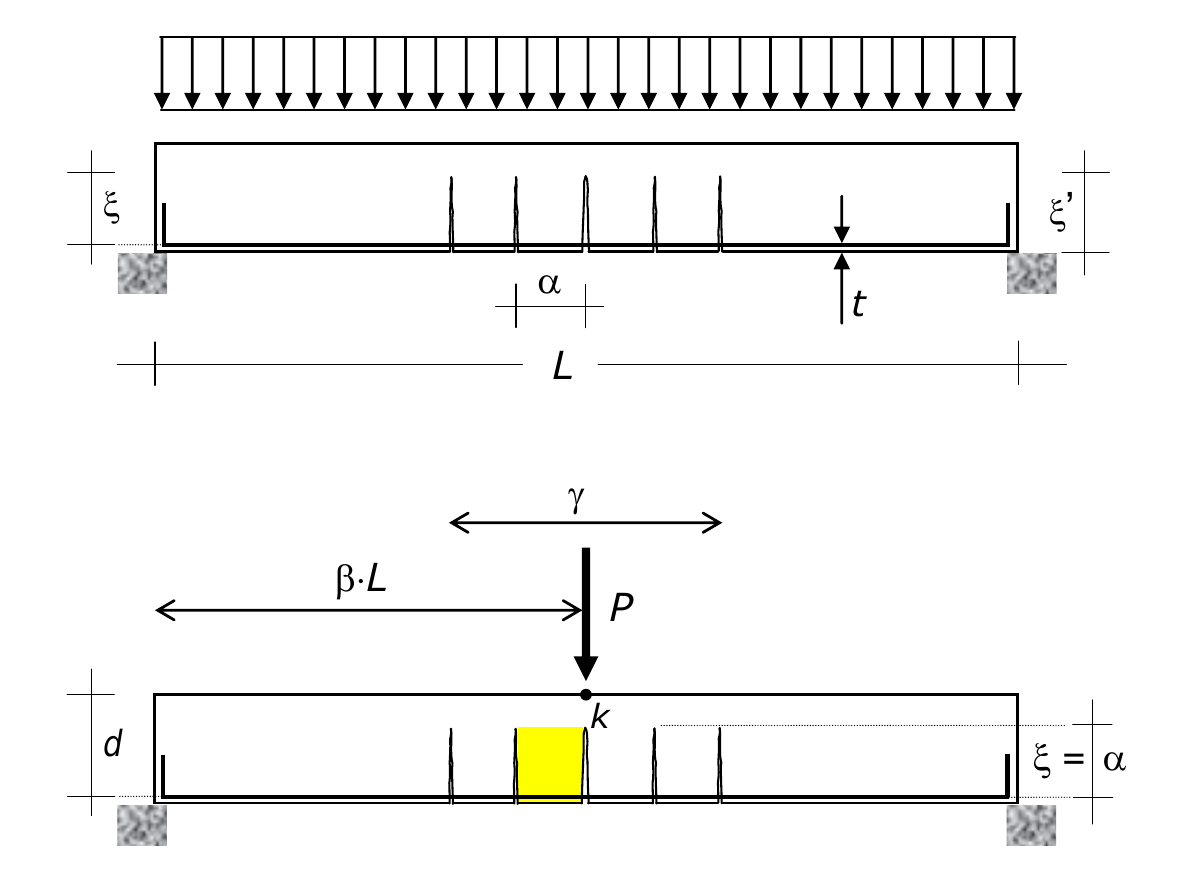
Figure 1. RC beam with vertical cracks around the midspan, which are spread along the length γ at spacing α. The upper diagram shows the loading condition that acted in the past and cracked the beam. The lower diagram shows the unstrengthened beam subjected to the new loading condition, i.e., the force P at point k , whose abscissa is β L (the beam could not bear that force). The figure also shows the span L , the depth t of the concrete cover, the crack depth ξ’, and the effective crack depth ξ. Failure is dictated by the shadowed cantilever.